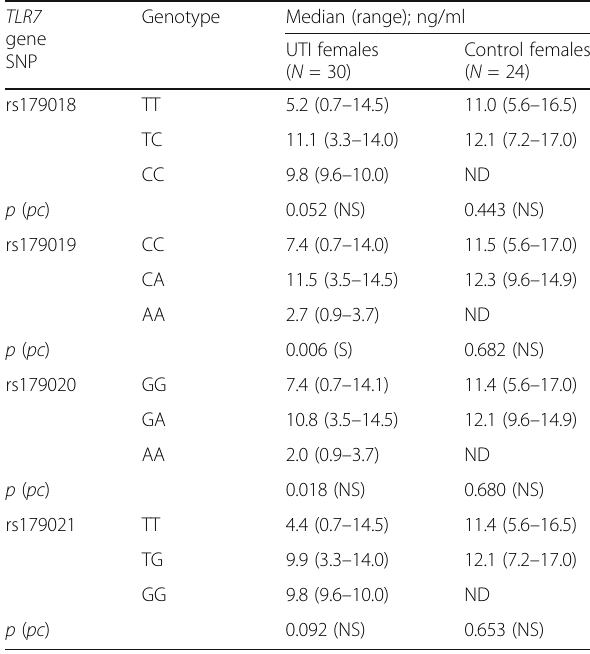
Table 6 Impact of TLR7 gene single-nucleotide polymorphisms on serum level of TLR-7 in females of urinary tract infection patients and